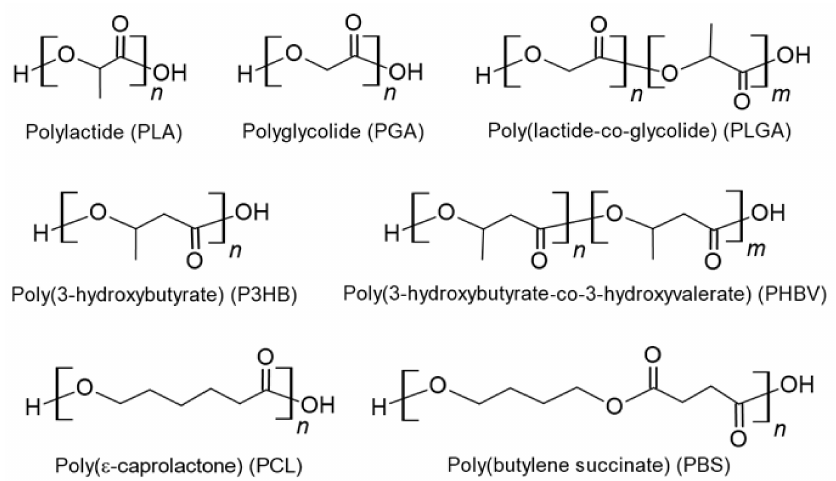
Figure 4. Structures of PLA, PGA, PLGA, P3HB, PHBV, PCL, and